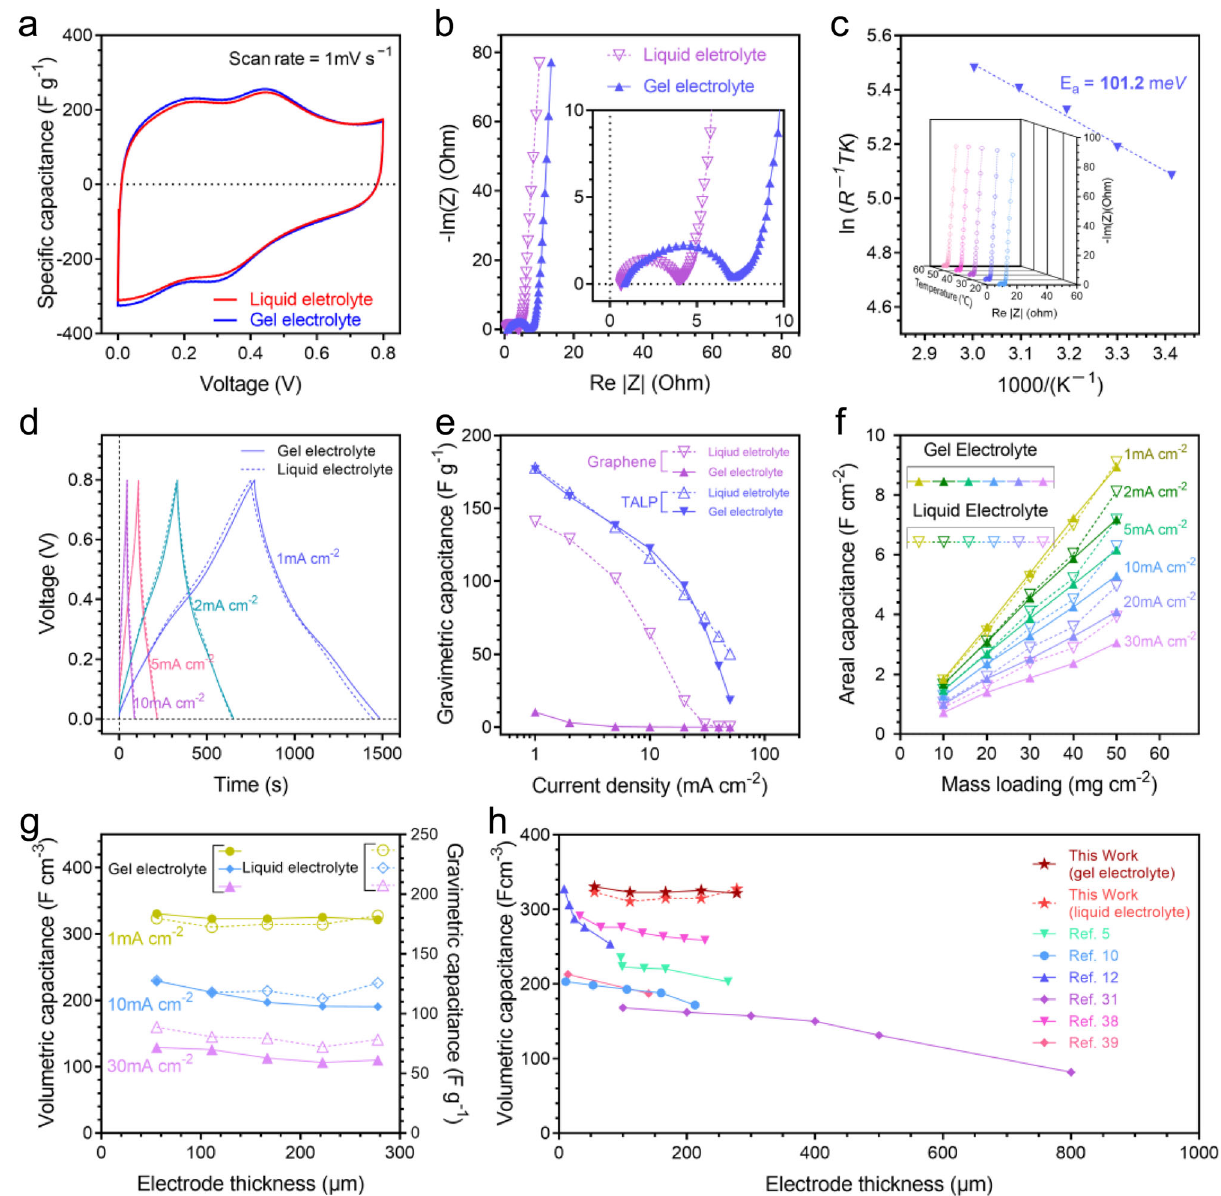
Fig. 3 Electrochemical behaviors and capacitive performance of TALP electrode. a CV pro fi les for TALP electrode in liquid and gel electrolytes. b Nyquist plots of TALP electrode with 10 mg cm − 2 mass loading in liquid and gel electrolytes. c The Arrhenius plot for the TALP electrode demonstrates the activation energy of ion transport in the nano fl uidic ion network in the TALP electrode. The inset is the Nyquist plots of TALP electrode at different temperatures. d Galvanostatic charge − discharge pro fi les for TALP electrode (10 mg cm − 2 ) in liquid and gel electrolytes. e The capacitance comparison among TALP electrode in different electrolytes and that of the graphene foam electrode. When gel electrolyte was used, the TALP and graphene foam were not soaked with any form of electrolyte. f The areal capacitance of TALP electrodes (mass loading ranging from 10 to 50 mg cm − 2 ) versus current densities (1 − 30 mA cm − 2 ) in gel and liquid electrolytes. g The relationship between electrode thickness and volumetric capacitance of TALP electrodes at different current densities. h The volumetric capacitance versus electrode thickness in liquid and gel electrolytes 5,10,12,31,38,39